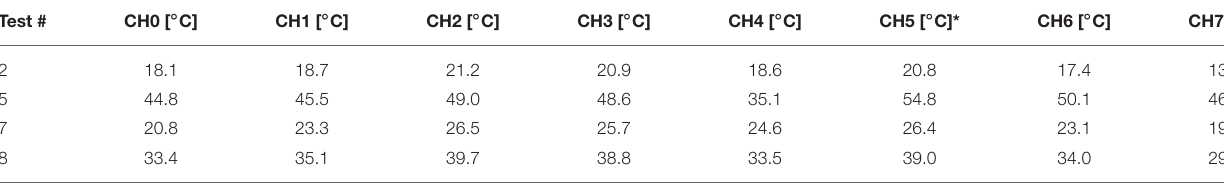
TABLE 3 | Maximum temperature increase measured by the eight thermocouples in the tests #2, #5, #7, #8.